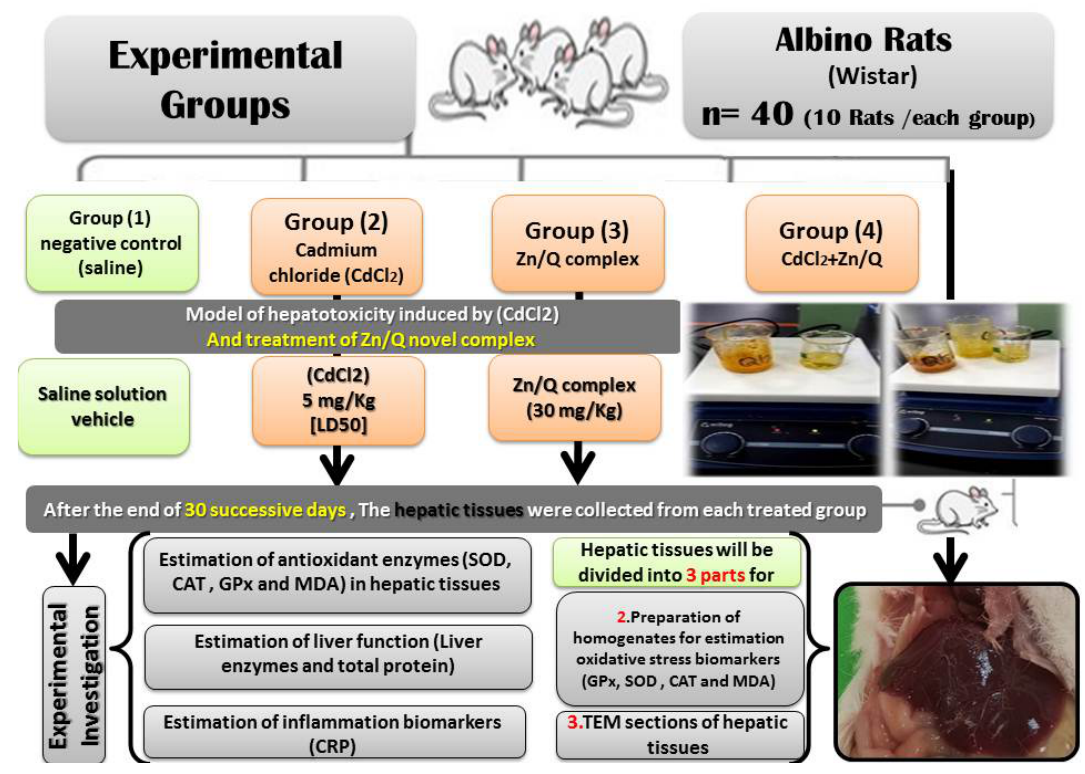
Figure 1. Experimental protocol.